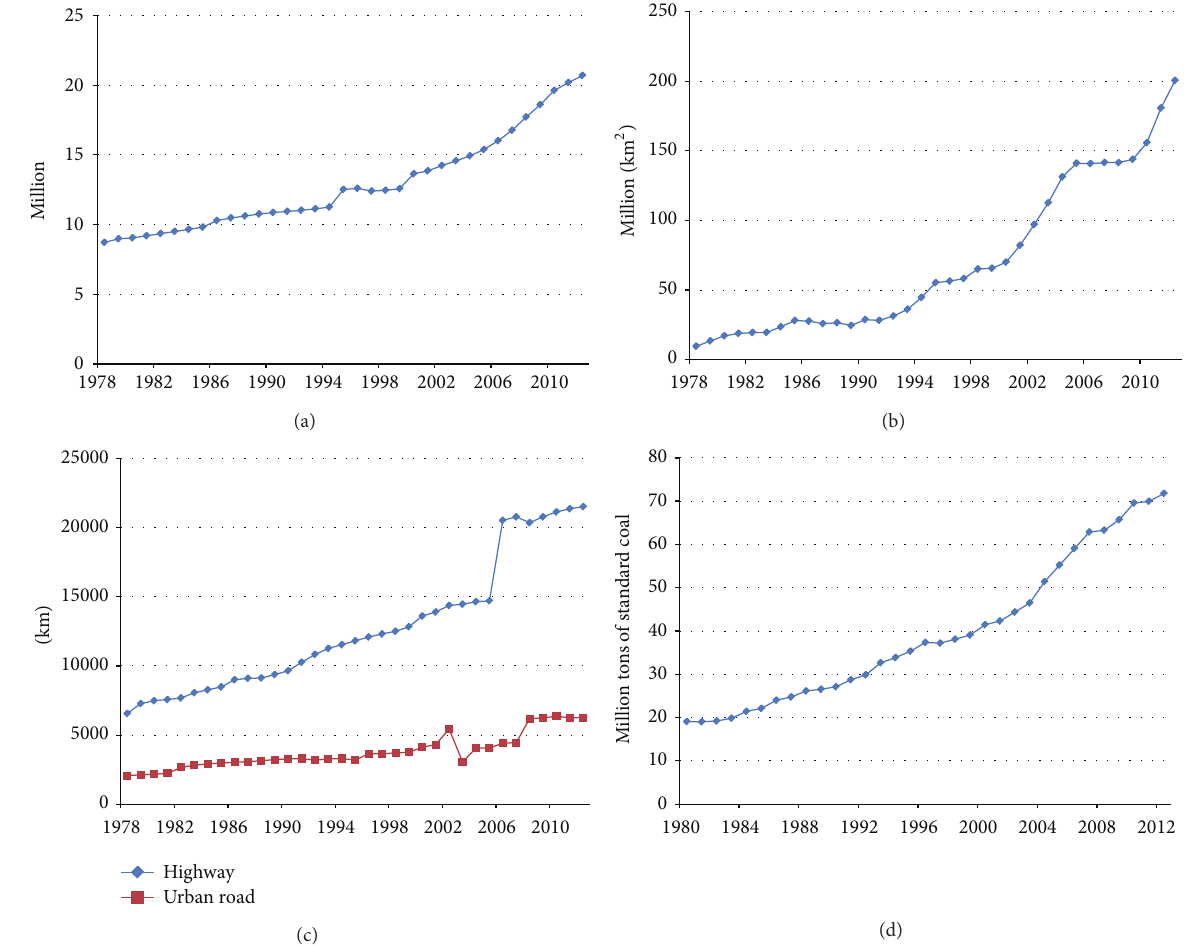
Figure 6: Resident population (a), construction area (b), length of highway and urban road (c), and total energy consumption (d) of Beijing in the period of